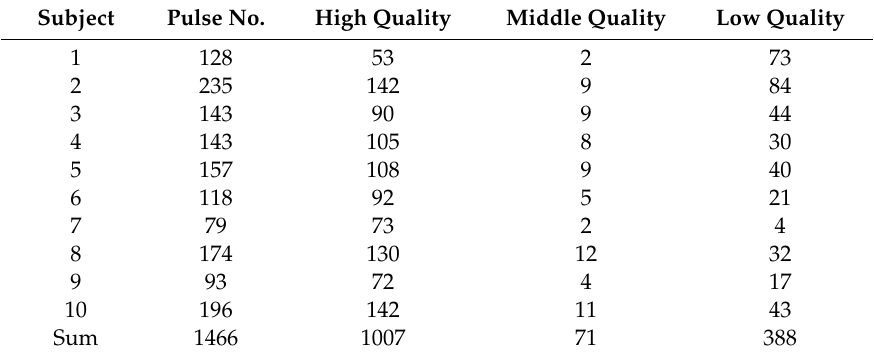
Table 6. Pulse number distribution for three quality levels of PPG pulses for each subject.